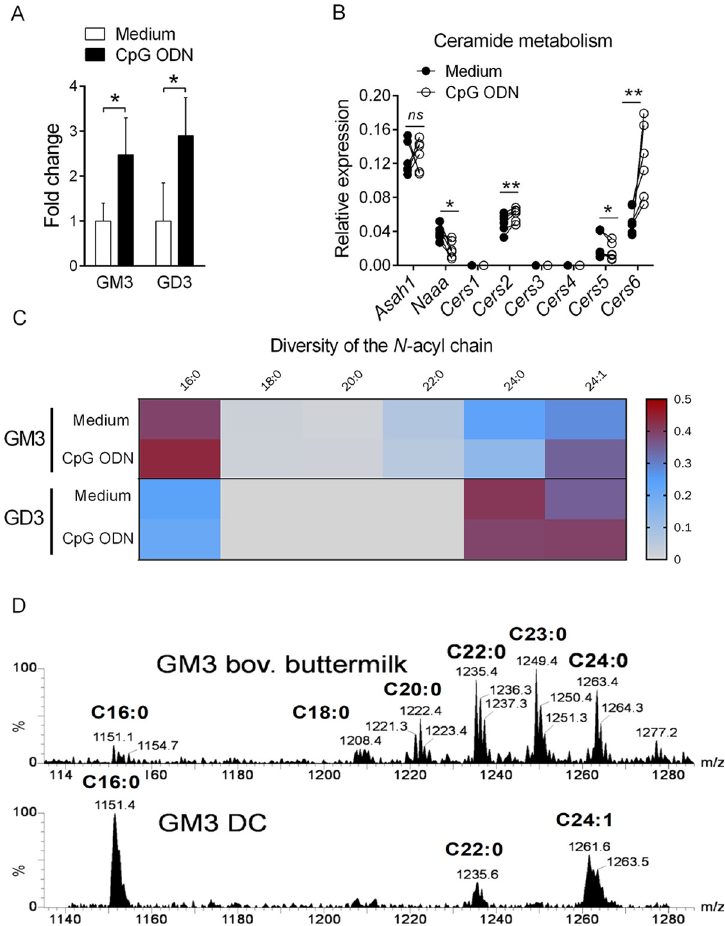
Fig 2. Modulation of ceramide and ganglioside metabolisms in DCs following CpG ODN treatment. (A) Increase of ES(-)-LC-MS/MS detected gangliosides GM3 and GD3 in CpG ODN-stimulated DCs shown as fold change relative to unstimulated cells (medium). Two sets of DCs were measured, and data are means ± SD. (B) RNAs from unstimulated or CpG ODN-stimulated DCs were harvested after 16 h stimulation, and Asah1 , Naaa , and Cers1-6 mRNA expression was measured by quantitative real-time PCR. Data represent paired individual values from six independent experiments. (C) Heatmap for DC N -acyl chain composition of GM3 and GD3 in unstimulated versus CpG ODN-stimulated cells measured by ES(-)-LC-MS/MS. Color code represents fractions of the total amount (1.0) of detected gangliosides, respectively. Two sets of DCs were measured and plotted as mean values. �� P < 0.01; � P < 0.05. (D) ES(-)-LC-MS/MS analysis of the acyl chain composition of GM3 commercial bovine buttermilk and from mouse unstimulated DCs. Profiles of one experiment out of two are shown. Underlying data used in the generation of this figure can be found in S1 Data. Cers, ceramide synthase; CpG, cytosine-phosphate-guanine; DC, dendritic cell; ES (-)-LC-MS/MS, electrospray(-)-liquid chromatography-mass spectrometry/mass spectrometry, ns, not significant; ODN,